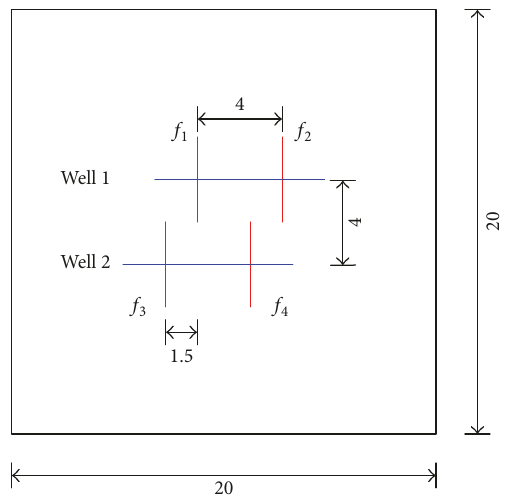
Figure 27: Two horizontal wells with two sets of parallel preset